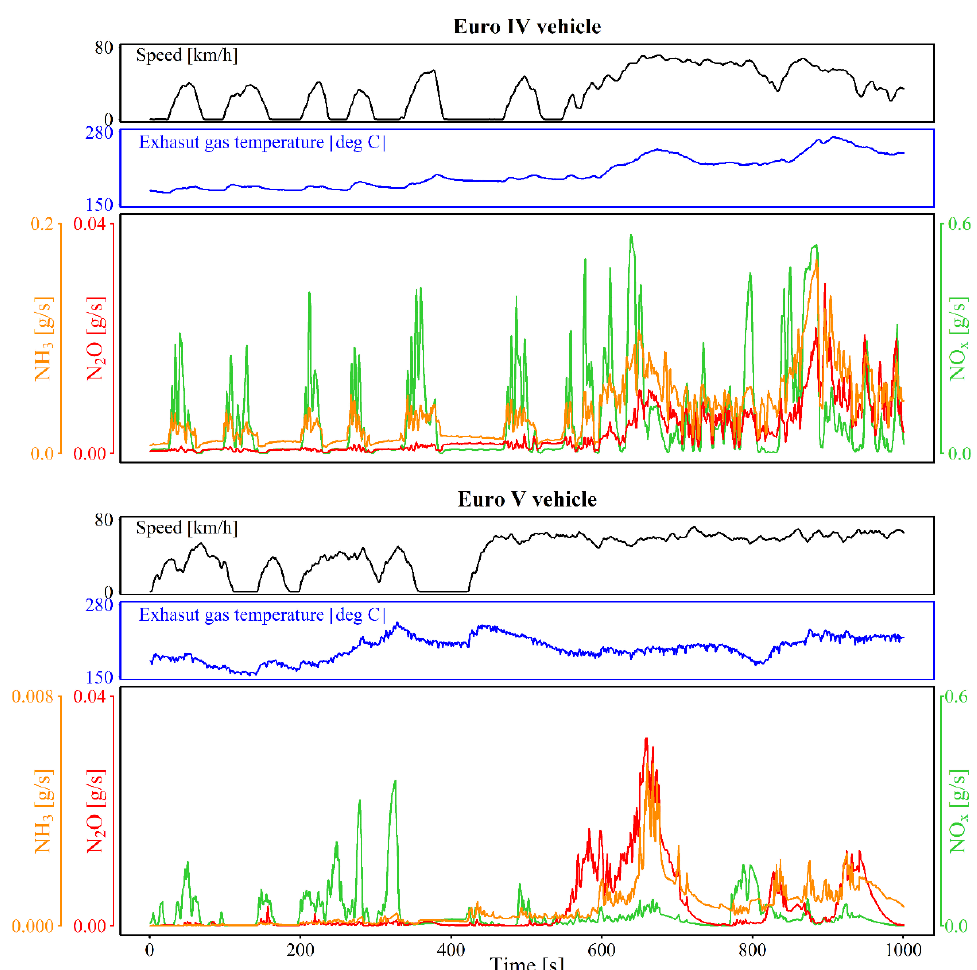
Figure 5. Example of a typical on-road trip of the Euro IV (DOC/EGR/SCR) and Euro V (DPF/SCR) vehicles. Profiles of NH 3 , N 2 O, and NO x mass rates, and exhaust gas temperature and vehicle speed signals.